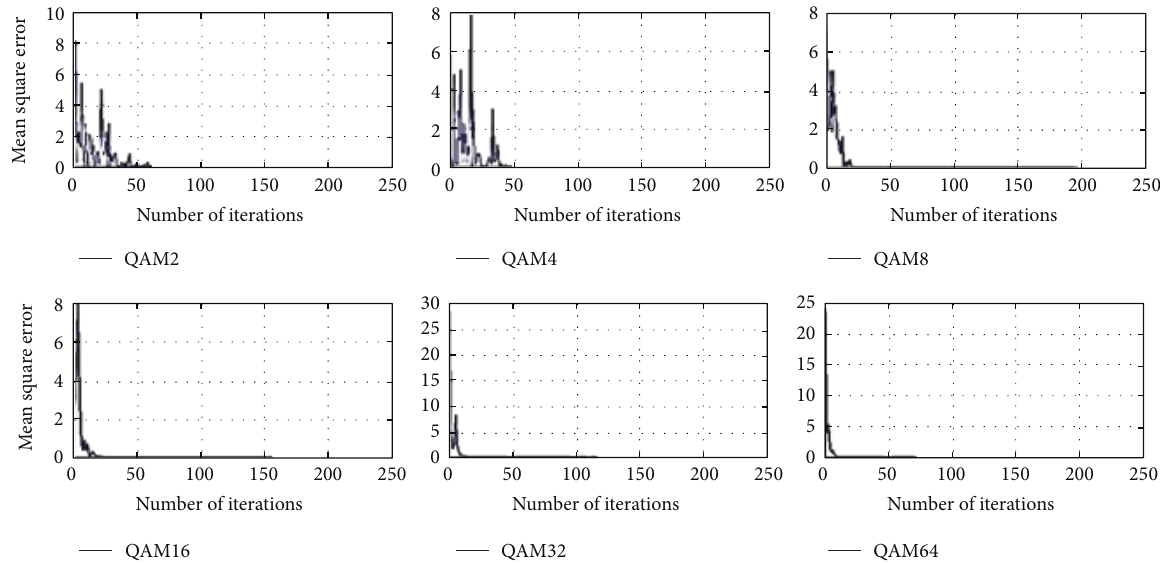
Figure6:TrainingofGaborfilterparametersandweightsformodulationclassificationincaseofQAM2–64fordifferentnumberofiterations at SNR = 10dB.